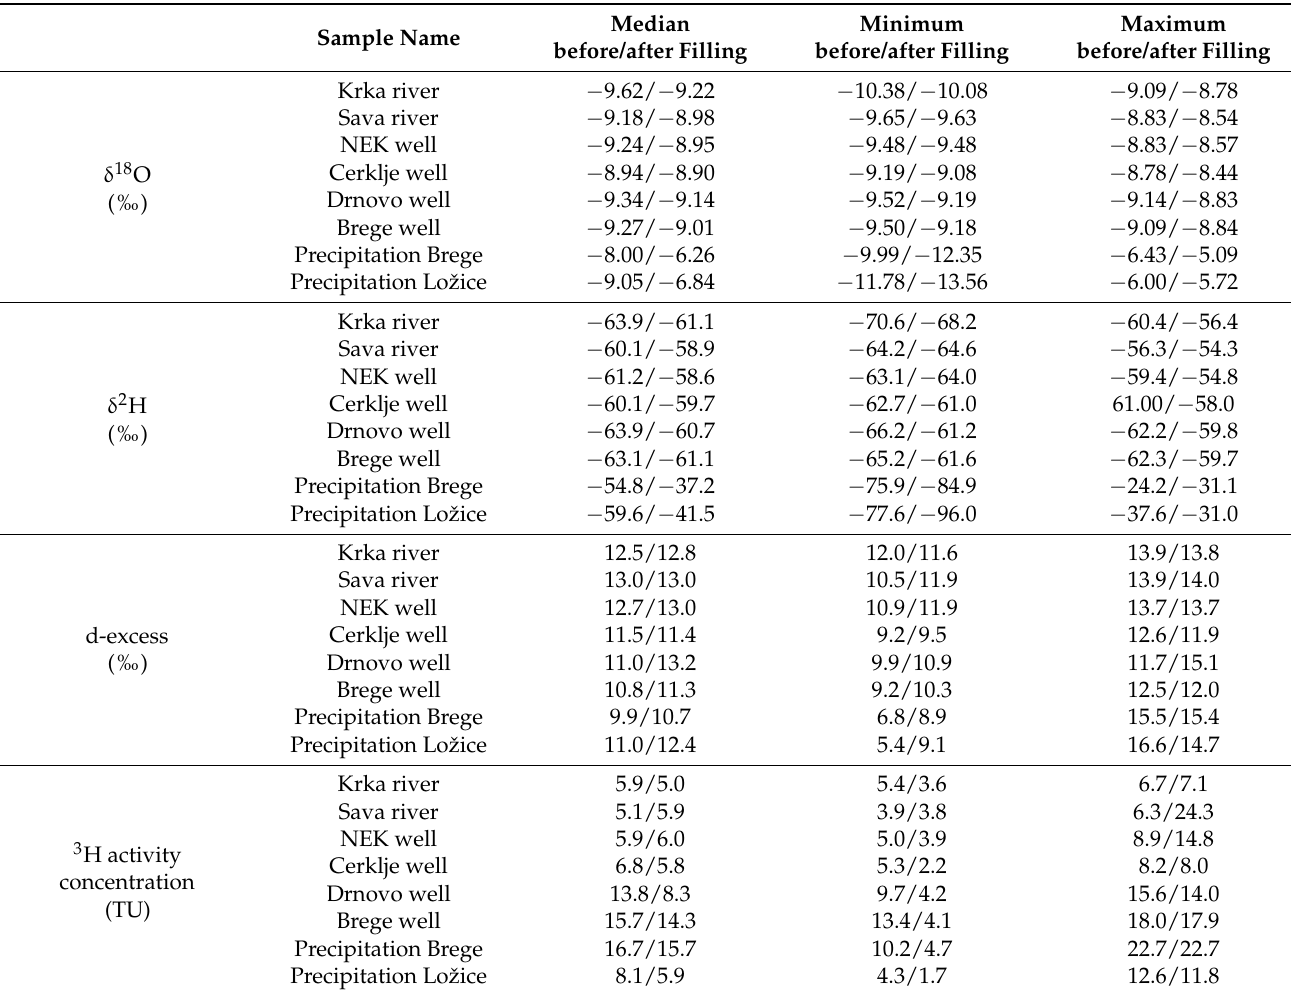
Table 2. Median, minimum, and maximum values of oxygen and hydrogen stable isotopic compo- sition, d-excess, and tritium activity concentrations before and after the filling of the accumulation basin for HPP